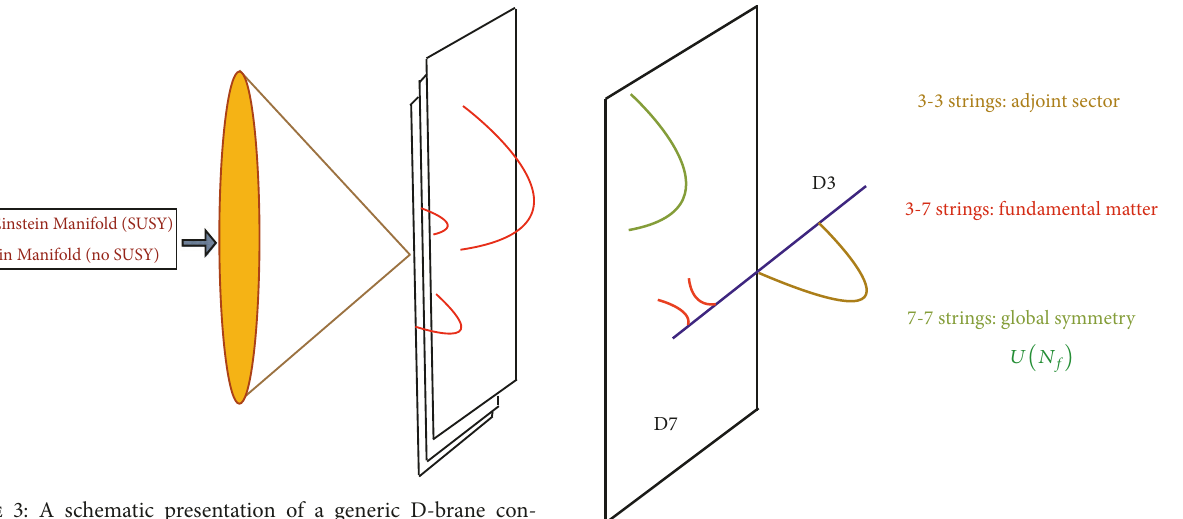
Figure 3: A schematic presentation of a generic D-brane con- struction. A certain 𝑁 number of D 3 -branes are placed on the tip of a cone, whose base could be a Sasaki-Einstein manifold (susy preserving), or simply an Einstein manifold (susy breaking). This picture assumes the cone is a six-dimensional manifold. This condition is not required and can be relaxed easily for other dimensional cases, at least, in principle. The red curves are strings beginning and ending on the stack of the D-branes, whose low energy limit can be captured by a standard gauge theory, similar to the N = 4 SYM.